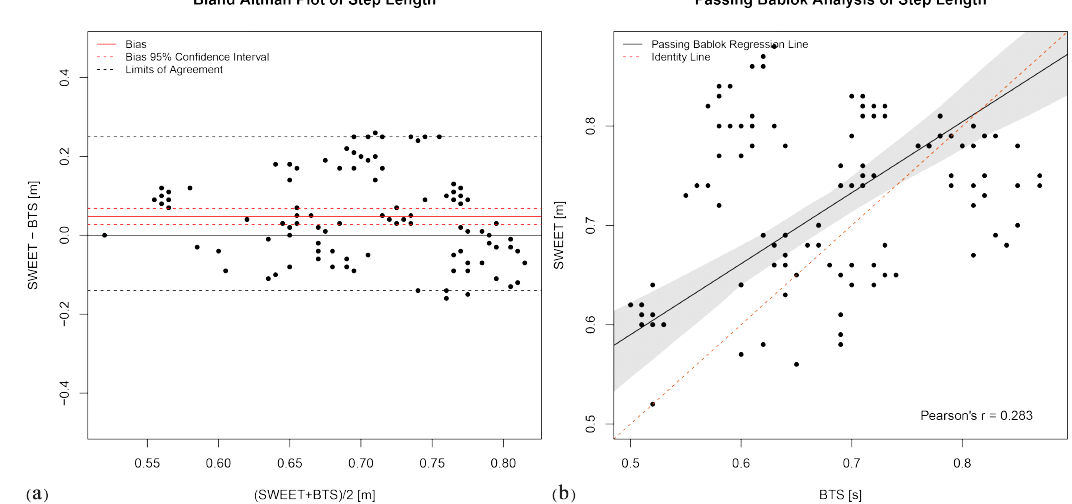
Figure 10. Step length: ( a ) Bland–Altman plot; ( b ) Passing–Bablok regression